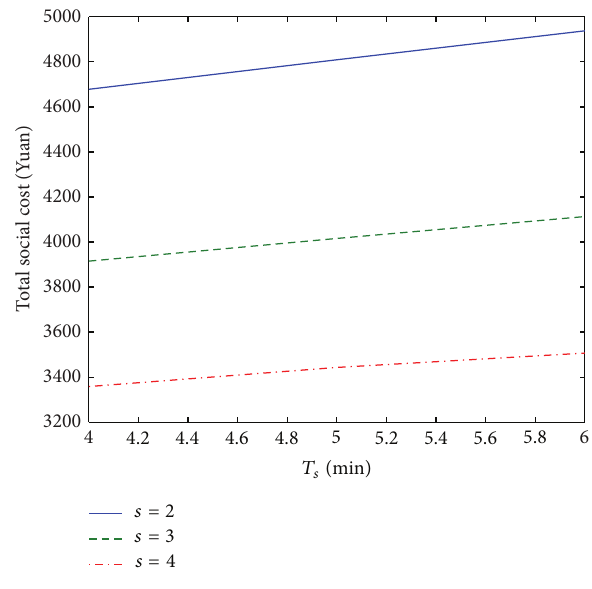
Figure 4: Total social cost versus 𝑇 𝑠 with different 𝑠 .